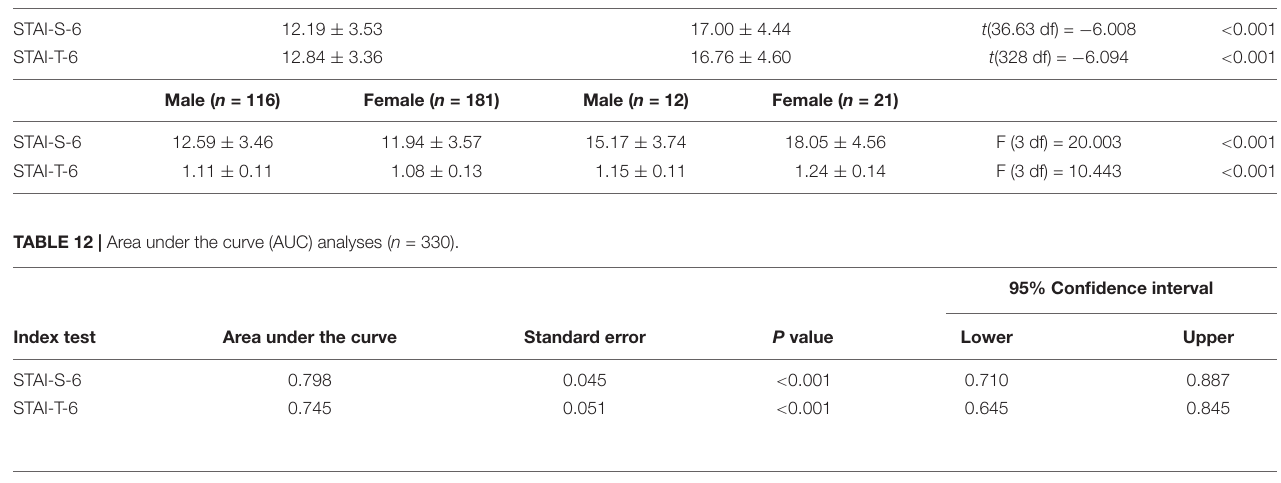
TABLE 11 | Empirical validity of the STAI-S-6 and STAI-T-6 in participants stratified by sex and mental state. No anxiety disorder ( n = 297)